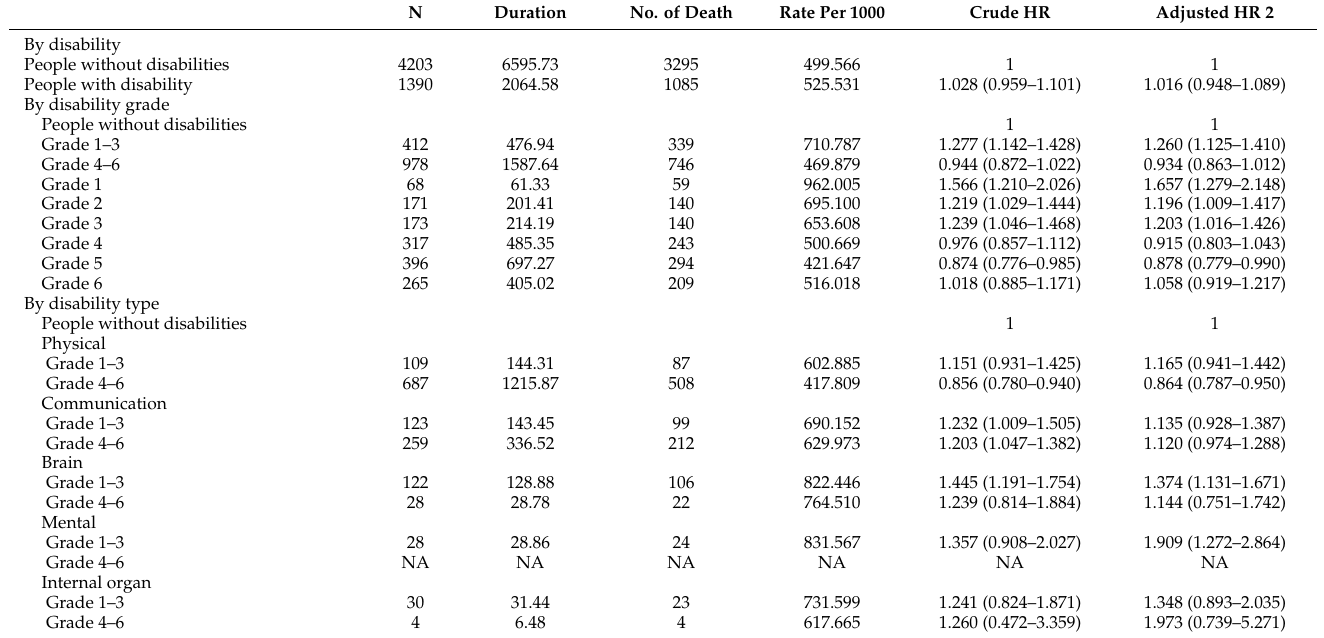
Table 7. Cancer-specific mortality in female patients diagnosed with bile duct